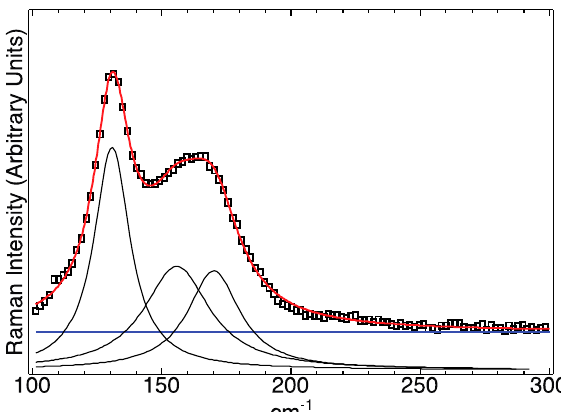
Figure 3. Deconvoluted CuInTe 2 spectrum shows peaks at 131, 156, and 170 cm − 1 . Black squares are actual data, and the red line is the sum of all the fitted components. The blue horizontal line is a fitted parameter to account for the background caused by ligand fluorescence.